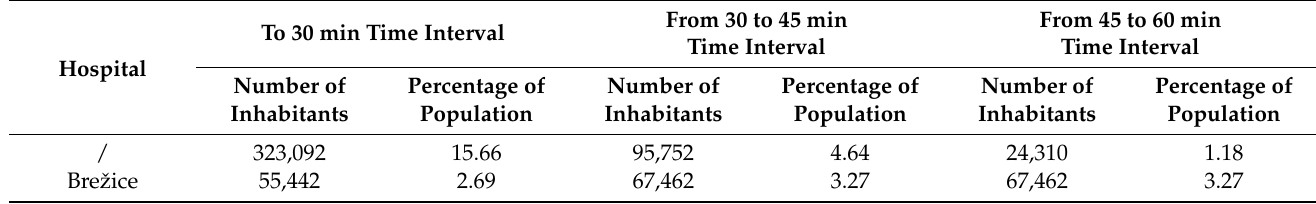
Table 4. Distribution of population across existing general